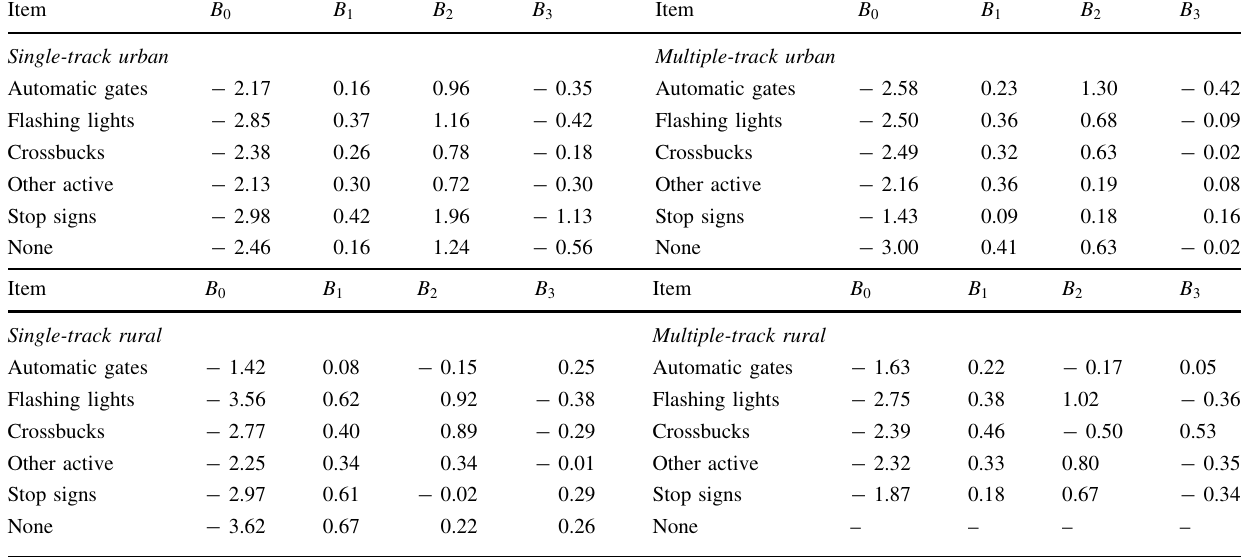
Table 3 Coleman–Stewart Model